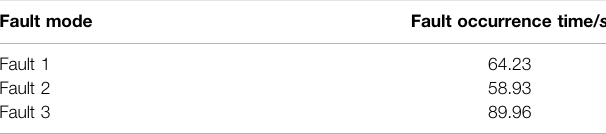
TABLE 2| Historical failure recordofwhich the time period is100 swith thefailure point included.